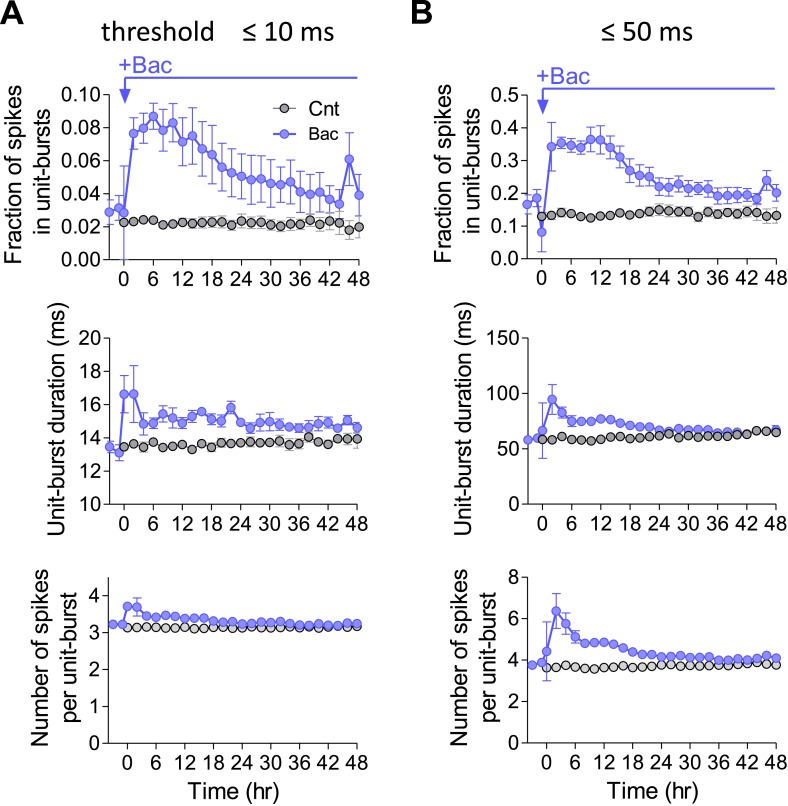
Single-unit burst characteristics are stable across a large range of thresholds.(A) Single-unit burst data for experiments from Figure 4D–G after using a burst threshold of 100 Hz, minimum three spikes per burst. (B) Single-unit burst data for experiments from Figure 4D–G after using a burst threshold of 20 Hz, minimum three spikes per burst.